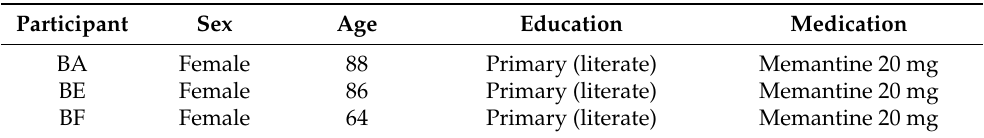
Table 1. Participants’ characteristics.